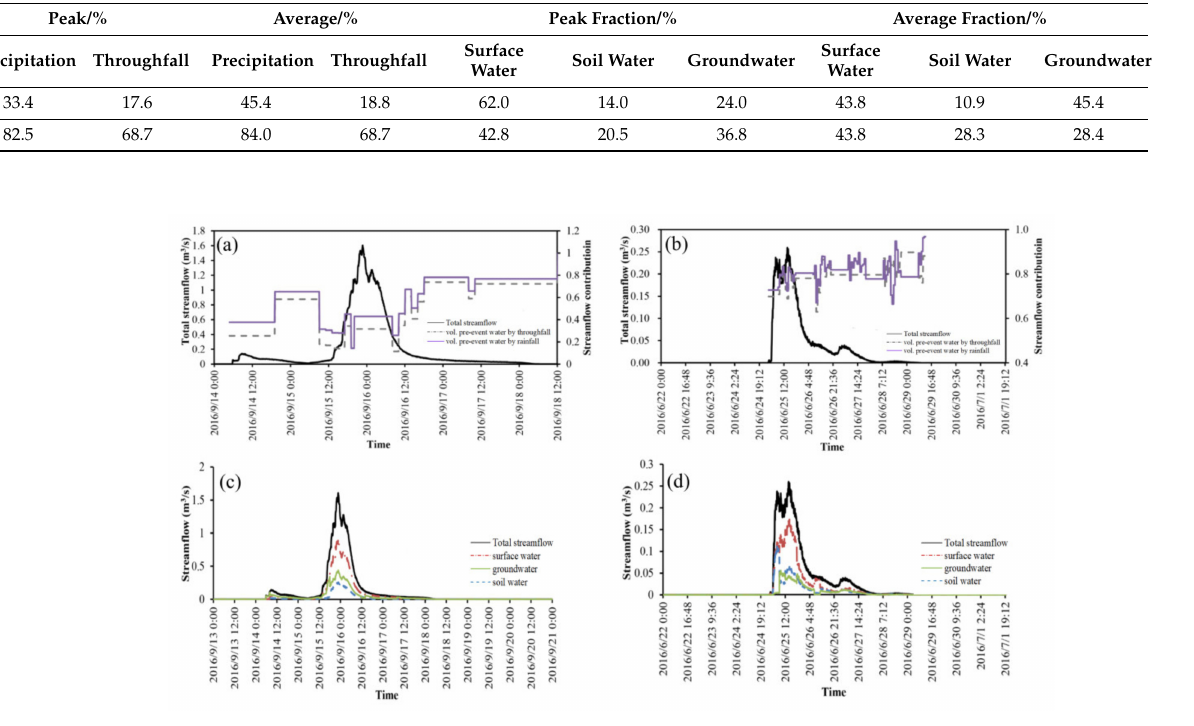
Figure 5. Results of isotopic hydrograph separation: ( a ) two-source model for typhoon, ( b ) two- source model for plum rain, ( c ) three-component model for typhoon, and ( d ) three-component model for plum